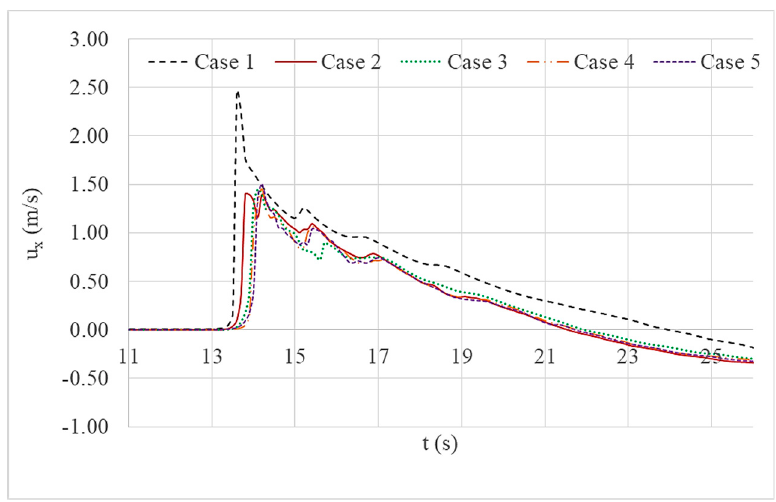
Figure 10. Comparison of current velocity (x-component) variations at location D.